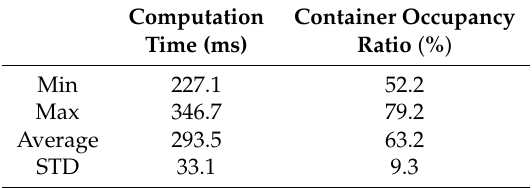
Table 2. The computation time and container occupancy ratio of the proposed